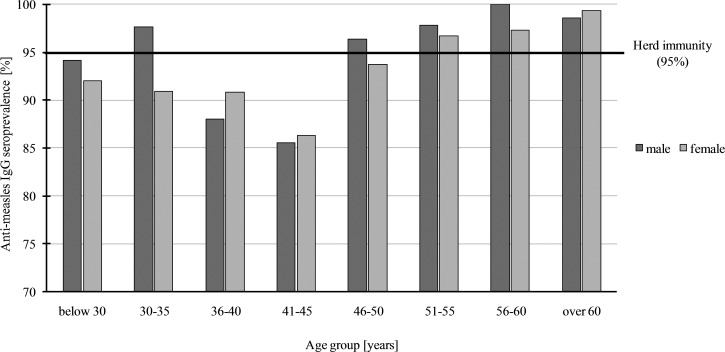
Measles seroprevalence in HCWs by gender and age groups in Military Medical Centre, Budapest, Hungary, 2017. There is a decrease in age group 36–45 in both genders which is considered significant, χ2 = 17 277; P = 0.0002 in men and χ2 = 45 748; P < 0.0001 in women. The horizontal line shows the herd immunity at 95%. In Hungary, the history of measles vaccination is the following: in 1969–1974 (44–49 years old) campaign vaccination in 9–23 months infants, with monovalent vaccine (Leningrad 16 strain); in 1974–1977 (41–44 years old) continuous vaccination of 10-month-old infants with monovalent vaccine (Leningrad 16 strain); 1978–1989 (29–40 years old) continuous vaccination of 14-month-old infants; 1989–1991 (27–29 years old) continuous vaccination of 14-month-old infants with monovalent vaccine (Rimevax) and revaccination at the age of 11 (Rimevax); 1991–1998 (20–29 years old) continuous vaccination of 15-month-old infants with trivalent vaccine (Pluserix) and revaccination at the age of 11 with monovalent vaccine (Rimevax).